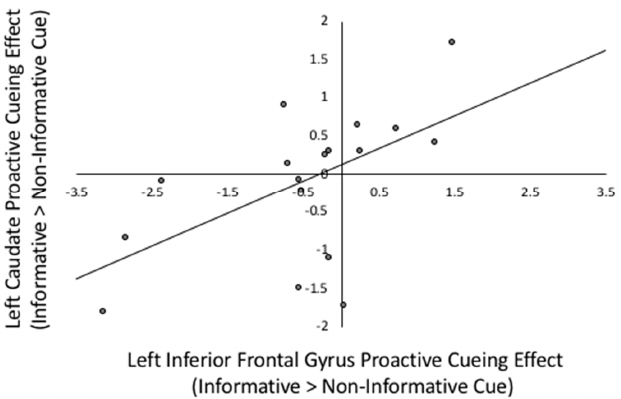
Figure 3. Scatterplot between left IFG proactive cueing effect and left caudate proactive cueing effect. Proactive cueing effect is the beta weight difference between informative cued > non-informative cued in Prepare Target Language phases, r (17) = 0.563, p = 0.019.